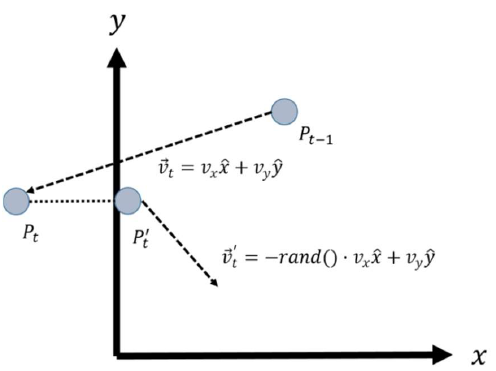
Figure 16. Boundary conditions for the Particle Swarm Optimization (PSO) developed in this research.